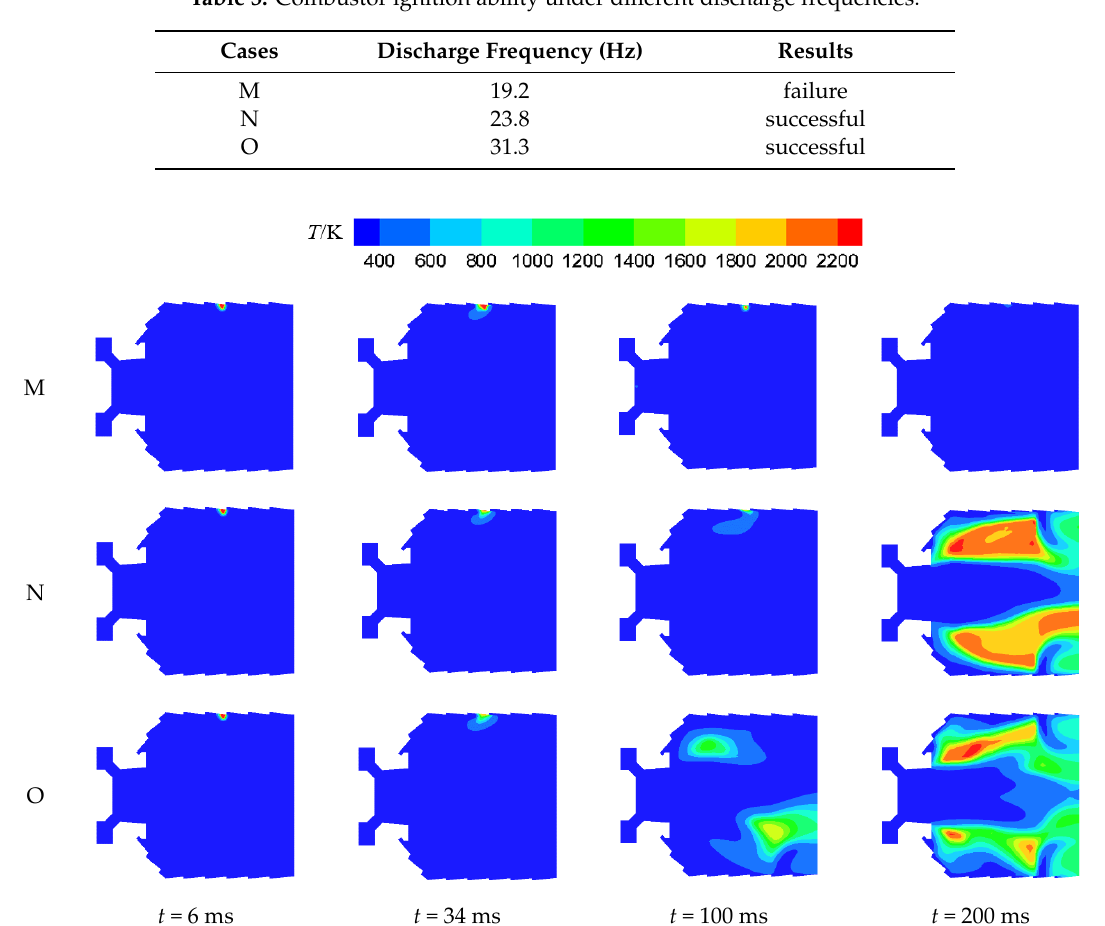
Figure 14. Numerical temperature field of combustor profile in Cases M–O.